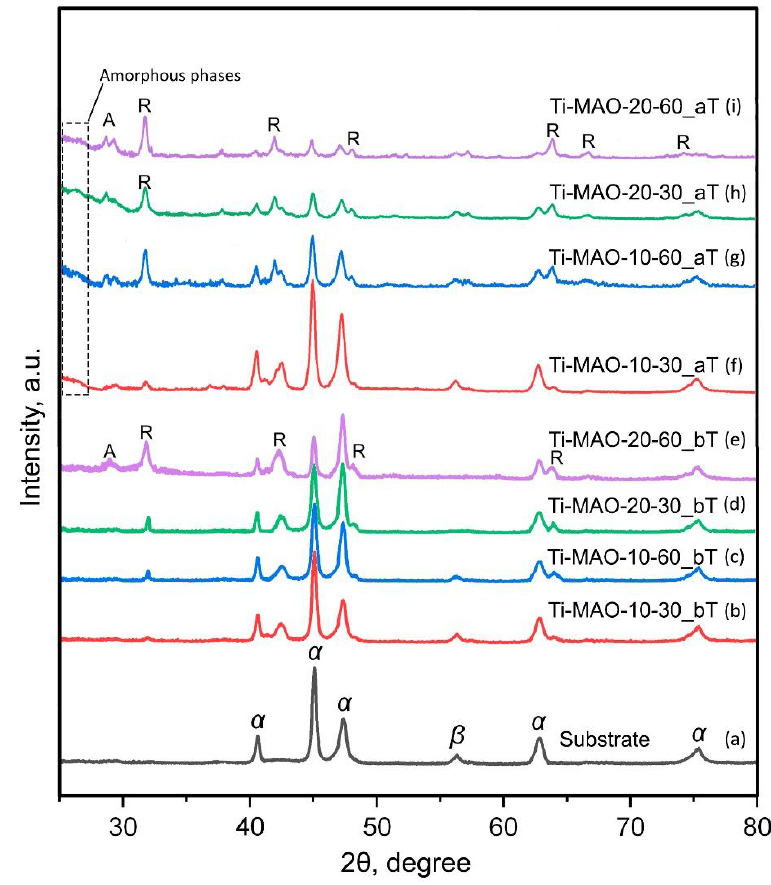
Figure 5. X-ray diffraction patterns of substrate ( a ) and samples with MAO coatings Ti-MAO-10-30 ( b , f ), Ti-MAO-10-60 ( c , g ), Ti-MAO-20-30 ( d , h ), and Ti-MAO-20-60 ( e , i ), before ( b – e ) and after ( f – i ) TCT. Α—α - Ti; β—β -Ti; A — TiO 2 -anatase; R — TiO 2 -rutile.